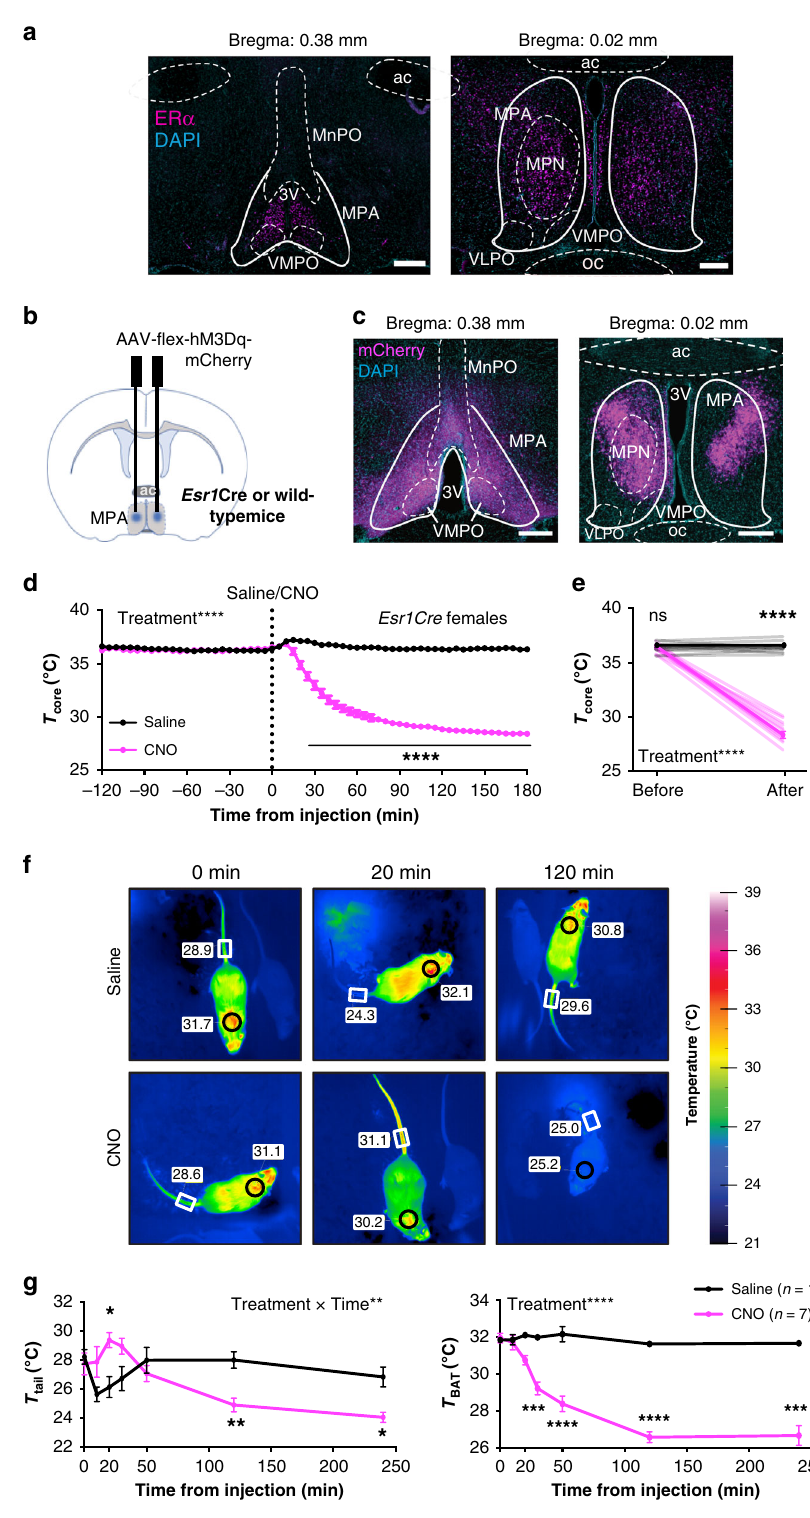
Chemogenetic activation of ER α + MPA neurons depresses temperature and metabolism . Analysis of the changes in body temperature revealed that a single CNO injection could induce a state of prolonged hypothermia. Of the 42 Esr1Cre females expressing hM3Dq and treated with CNO, 31 mice (74%) exhibited a core body temperature below 31 °C and 12 mice (29%